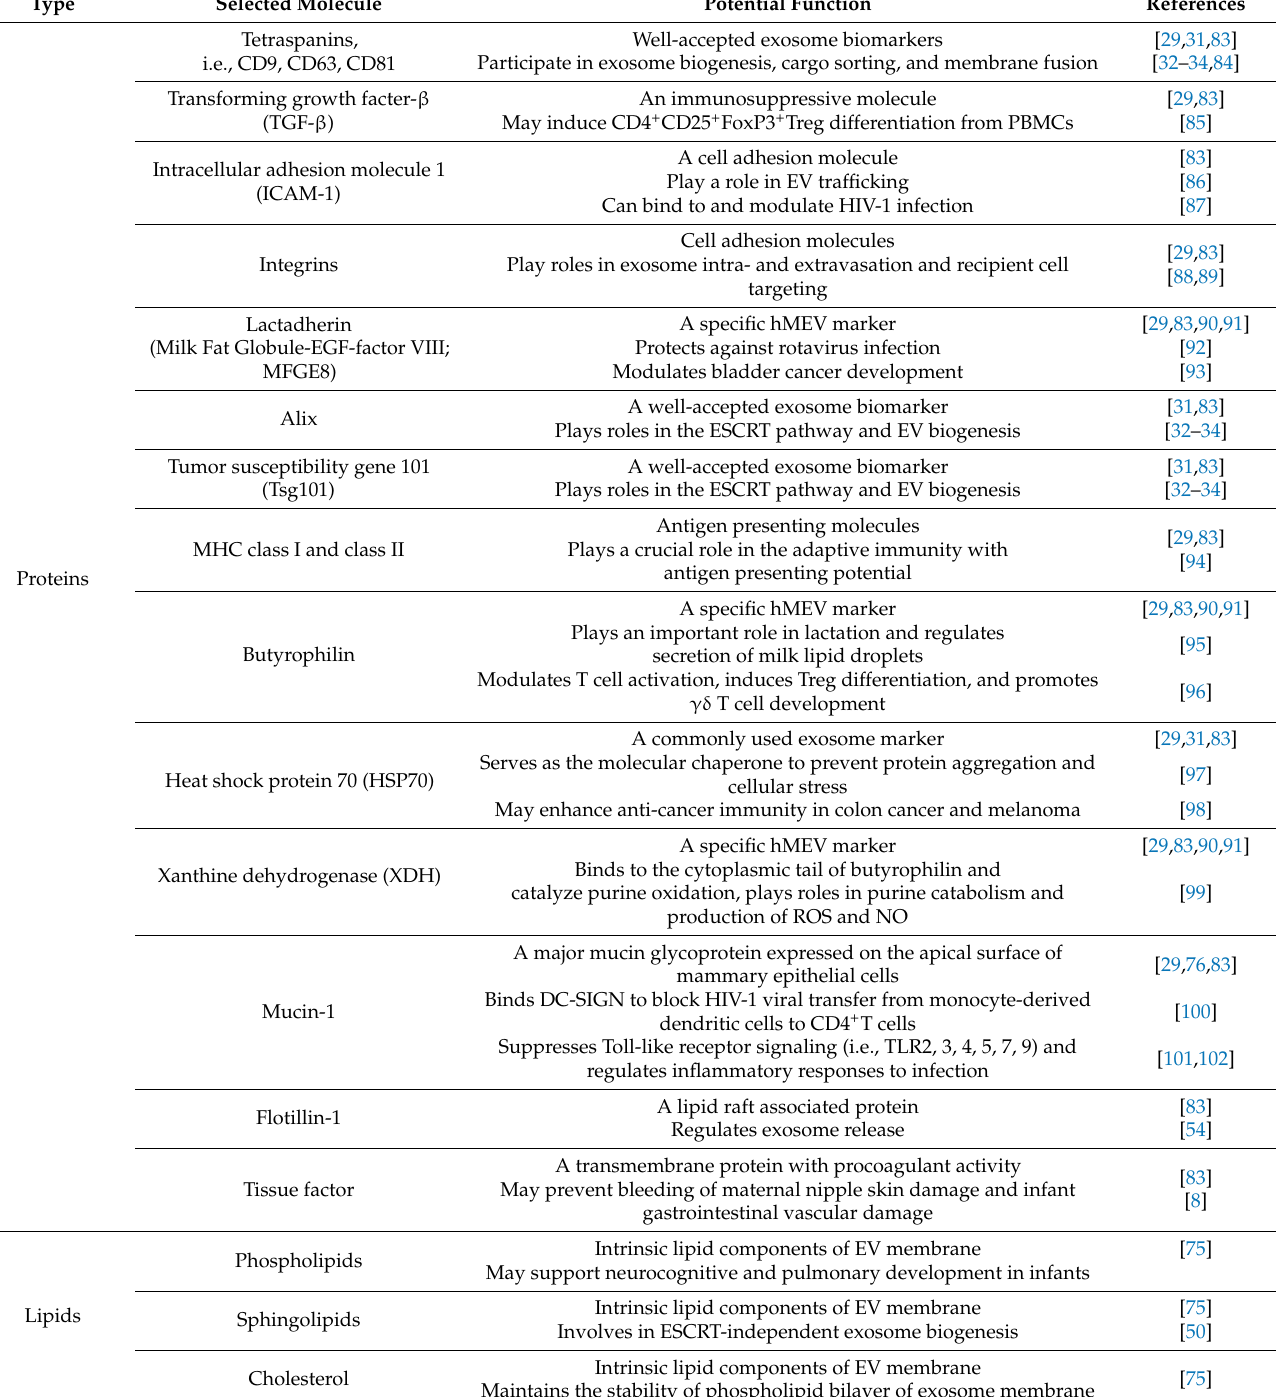
Table 1. Selected hMEV molecules and their potential